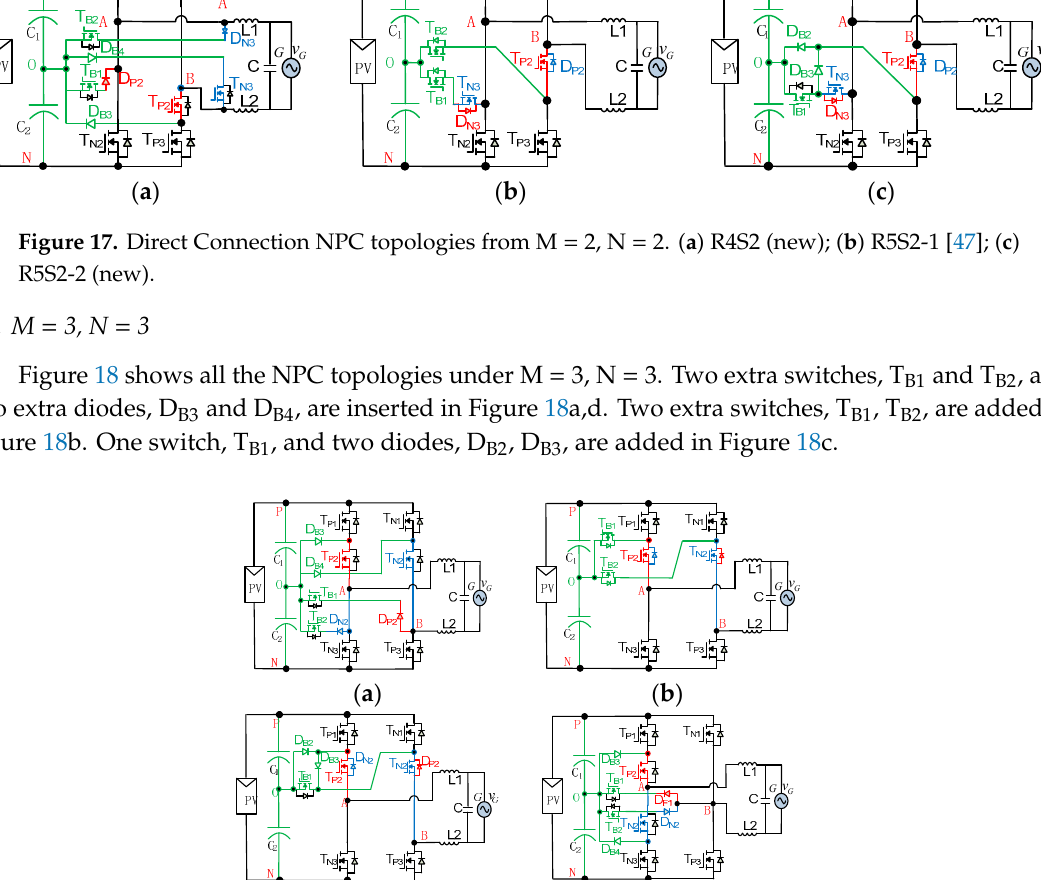
( b ) Figure 19. Direct Connection NPC topologies from M = 3, N = 3. ( a ) R9S2 (new); ( b ) R10S2 (new). 4.6. M = 4, N = 4 Figure 20 shows all the NPC topologies under M = 4, N = 4. Figure 20a is given as an example to describe the current flowing. In PF or NF mode, there are two branches for the flow of positive current. One is as follows: Point B → D P2 → T B1 → D B5 → T P2 → Point A, and the other is from Point B → T P3 → D B6 → T B2 → D P3 → Point A. Similarly, there are two branches for the flow of negative current. The first one is as follows: Point A → D N2 → T B3 → D B7 → T N2 → Point B. The other is from Point A → T N3 → D B8 → T B4 → D N3 → Point B. G G v ( c ) Figure 20. Direct Connection NPC topologies from M = 4, N = 4. ( a ) R11S2 (new); ( b ) R12S2 (new); ( c ) R13S2 (new). 5. Two Types of NPC Cells and Reflected Topologies under DFUSPWM